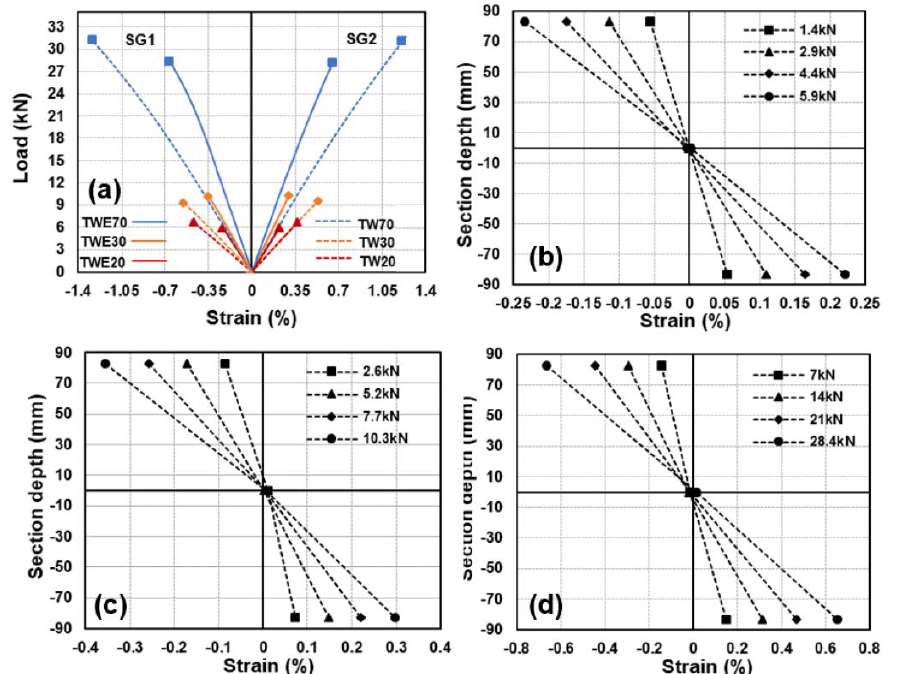
Figure 8. Strain responses at midspan (section D). ( a ) Load–strain responses for TWE specimens in comparison to TW specimens without environmental exposure from [45,46]; ( b ) strain distribution along depth for TWE20; ( c ) strain distribution along depth for TWE30; and ( d ) strain distribution along depth for TWE70.